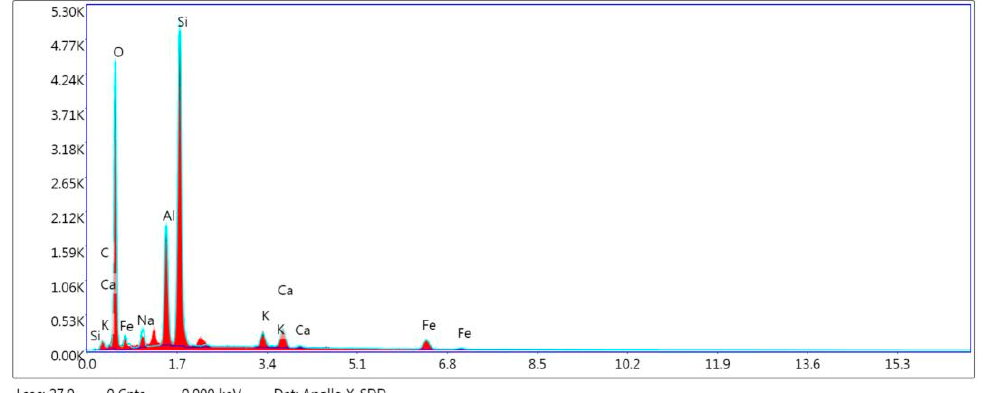
Figure 13. Energy spectrum of each element in A-0 soil sample energy spectrum area.